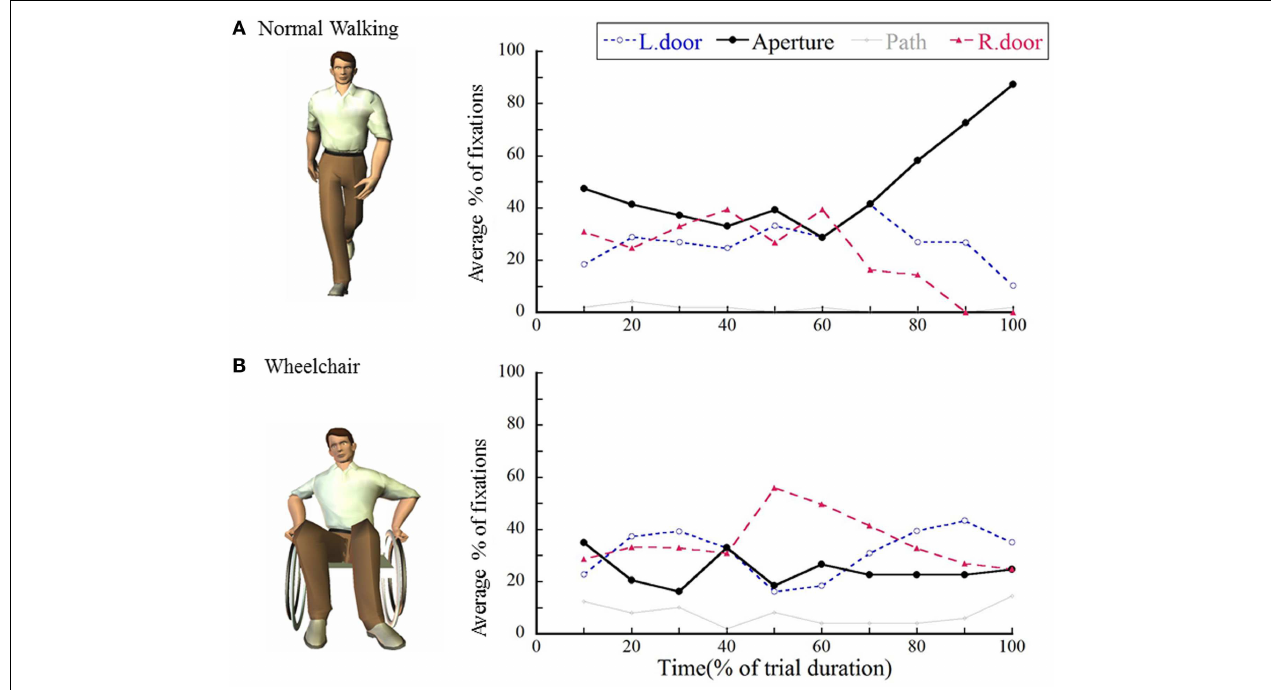
trial (0% corresponds to the initiation of the trial, and 100% corresponds to the time of crossing).This figure is reproduced with permission from Higuchi et al.